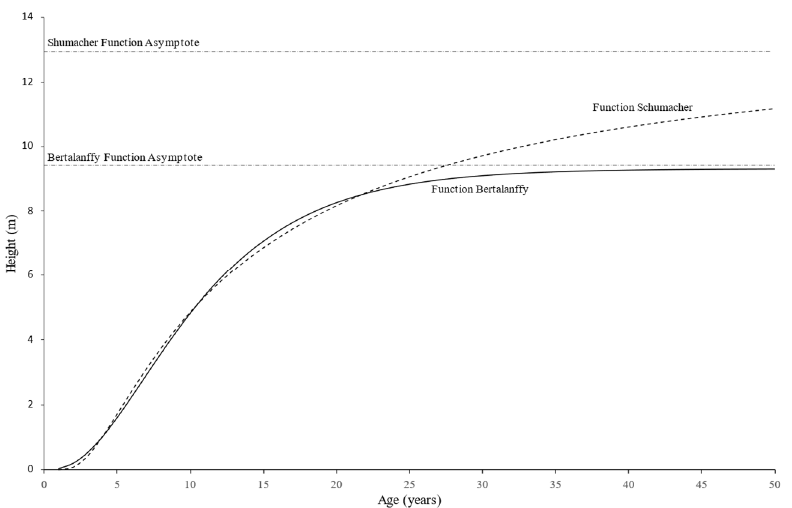
Figure 8. Evolution of height growth models for A. dealbata calculated from the Schumacher and the Bertalanffy equations. Table 10. Comparison of the descriptive parameters calculated for each of the datasets.